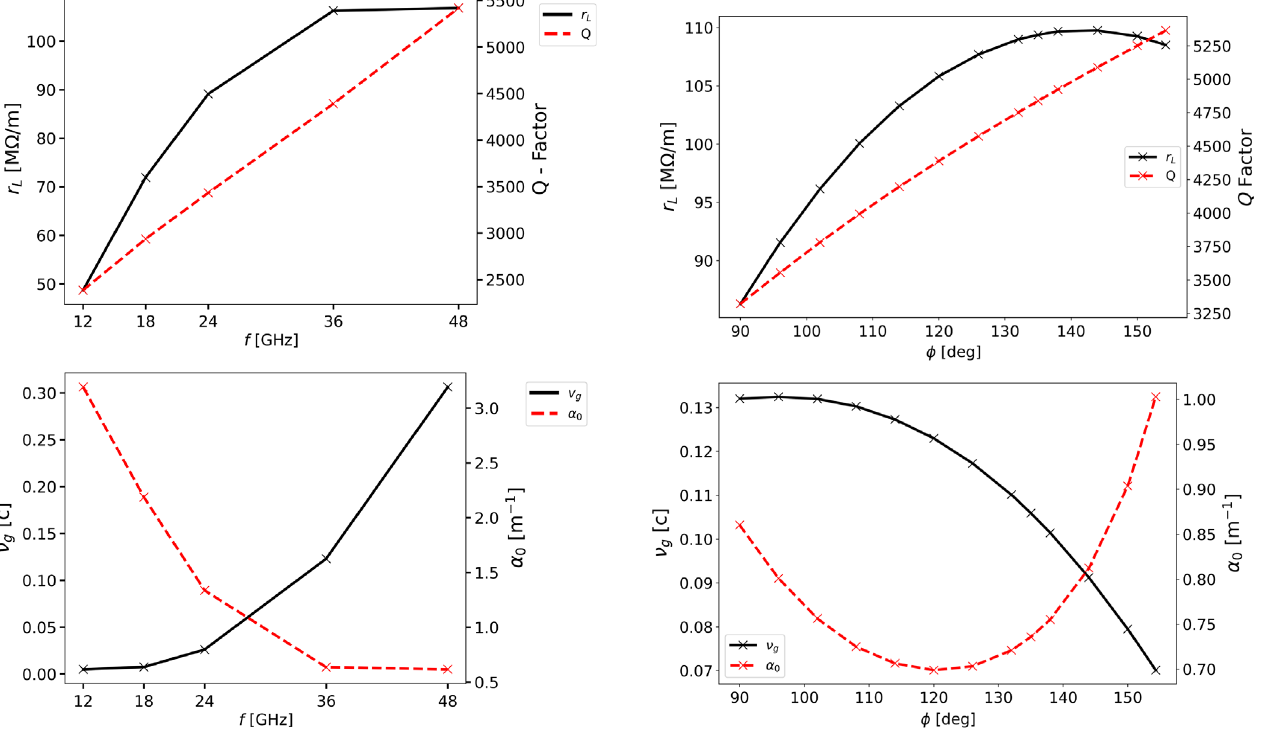
FIG. 5. Parameter comparison of a 36-GHz single cell with a 2-mm iris radius for different phase advances.